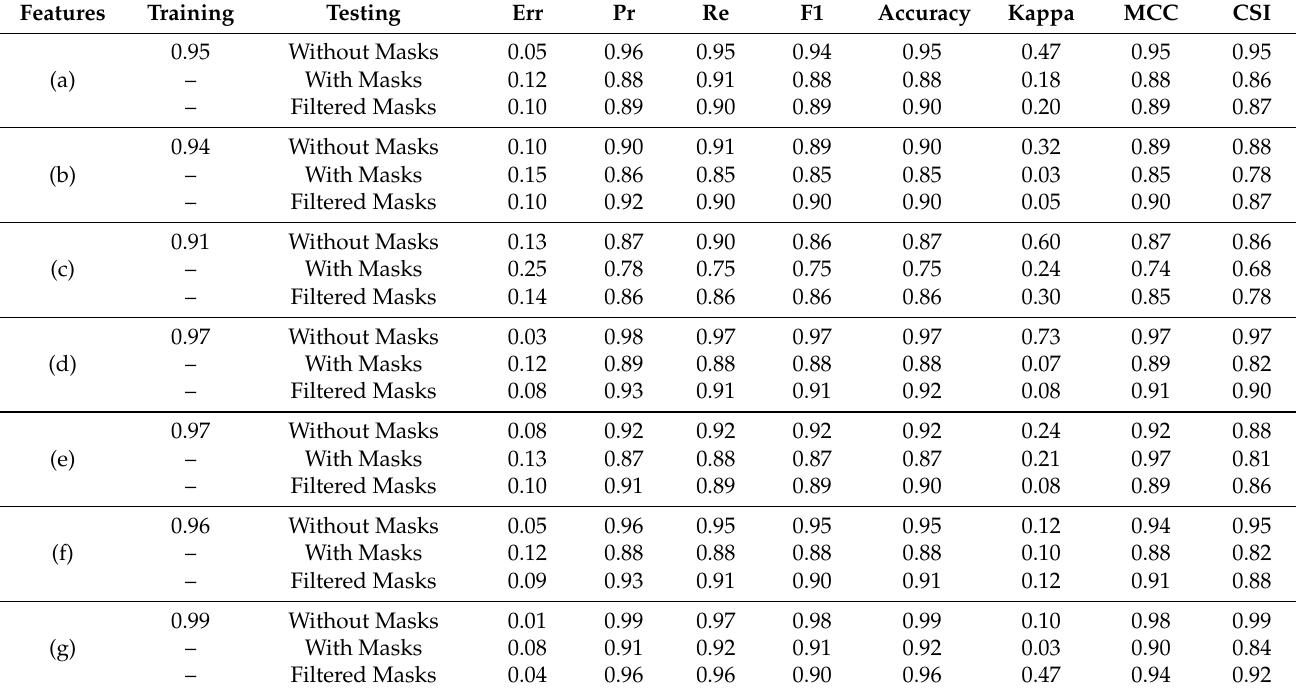
Table 3. Comparative analysis of the proposed and other spectral features with (a) TDoP (b)